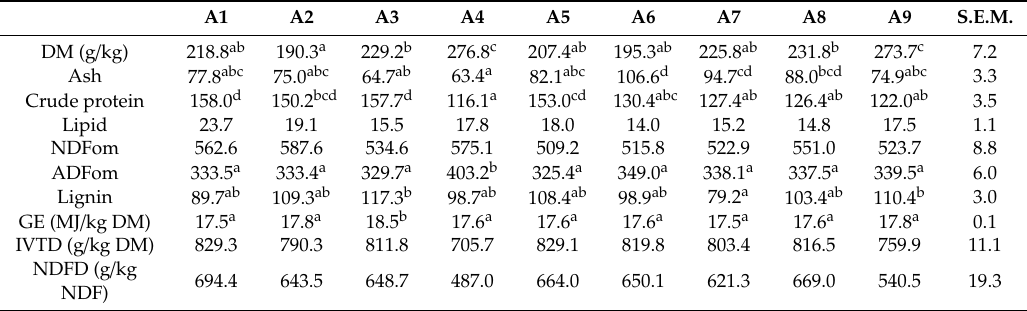
Table 2. Chemical composition (g / kg DM basis), gross energy (GE), in vitro true digestibility (IVTD), in vitro neutral detergent fiber digestibility (NDFD) of the pastures (A1–A9).